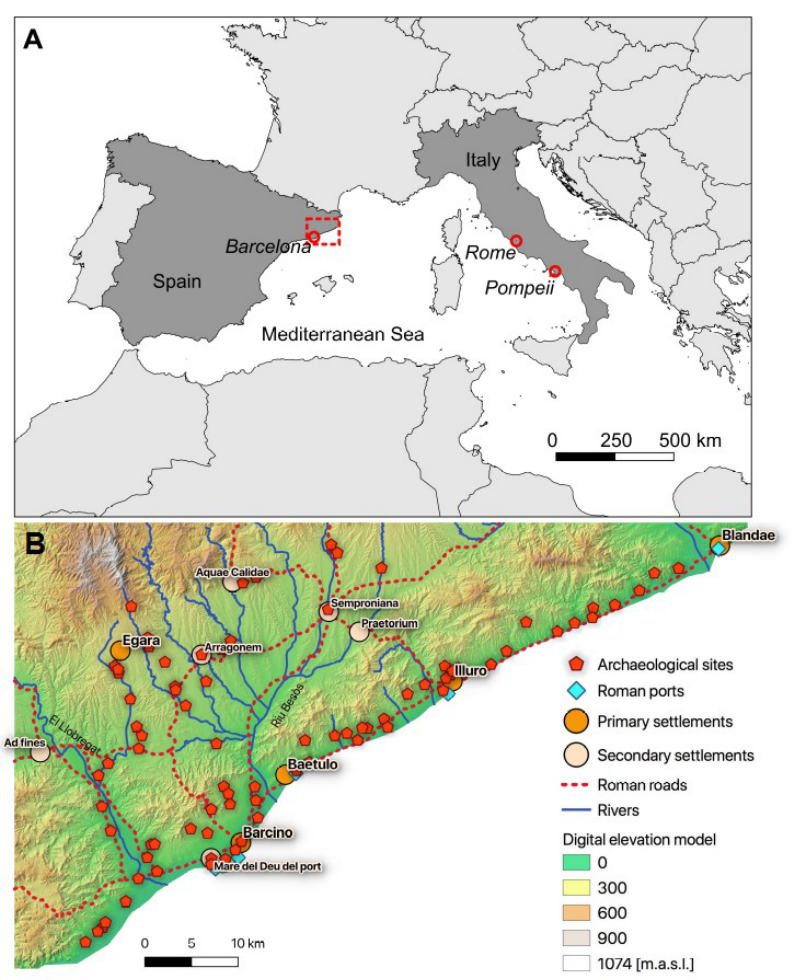
Figure 1. ( A ) Map of Southern Europe with the location of the research area (red rectangle) and ( B ) digital elevation model of the Laetanian Region with the locations of archaeological sites and socio- economic points of interest.